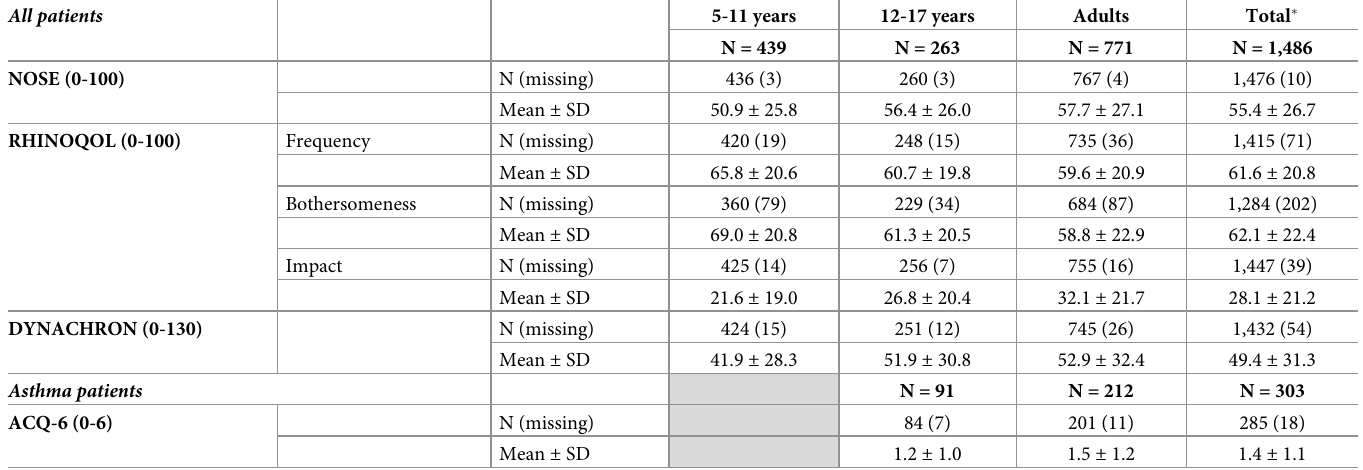
Table 2. Results from